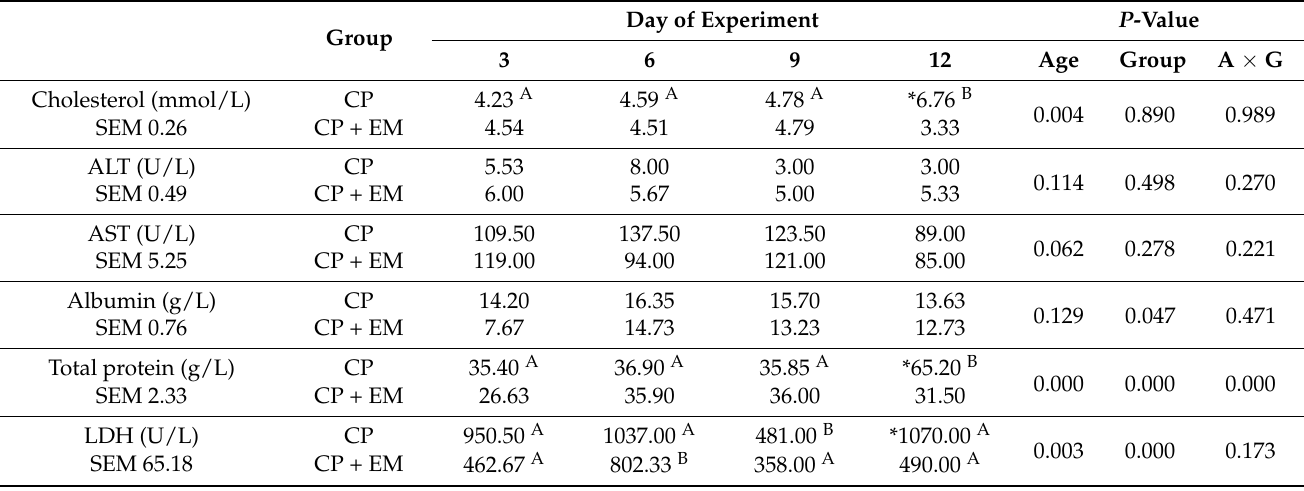
Table 5. Effect of EM supplementation on blood enzymes, albumin, total protein, and cholesterol level in quails challenged with C. perfringens